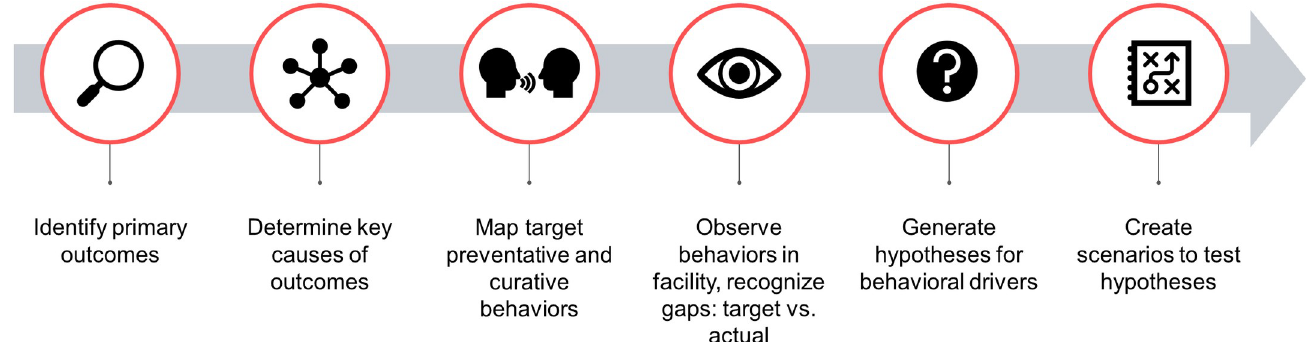
Fig 2. Pipeline showing the main components of the Providers Outcomes Pathway (POP) to develop interview guides and scenarios for the decision-making game. For the full Providers Outcomes Pathway used, see S1 Fig.